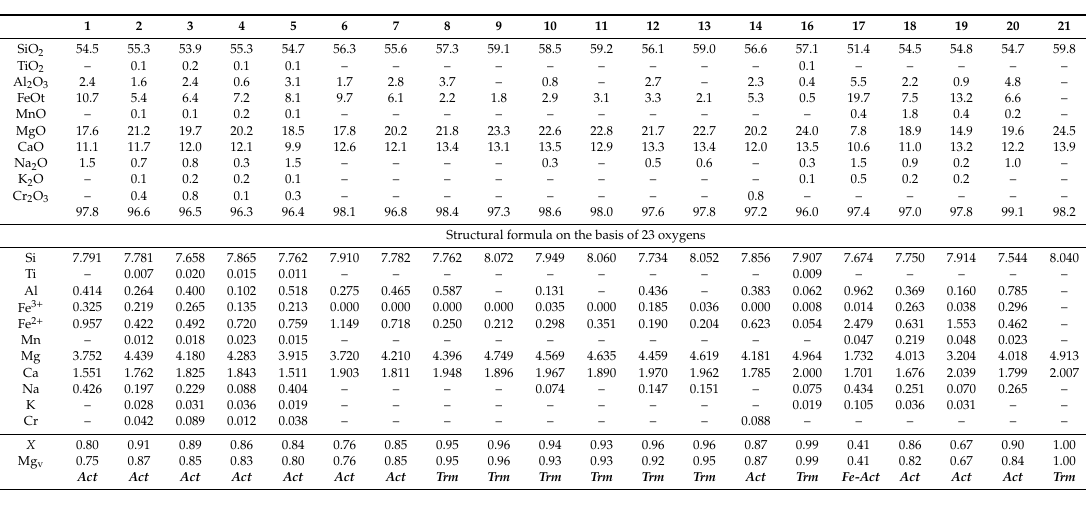
Table 2. RepresentativecompositionsoftheinvestigatedamphibolesobtainedbySEM-EDS. Act = actinolite, Trm = tremolite, Fe-Act =